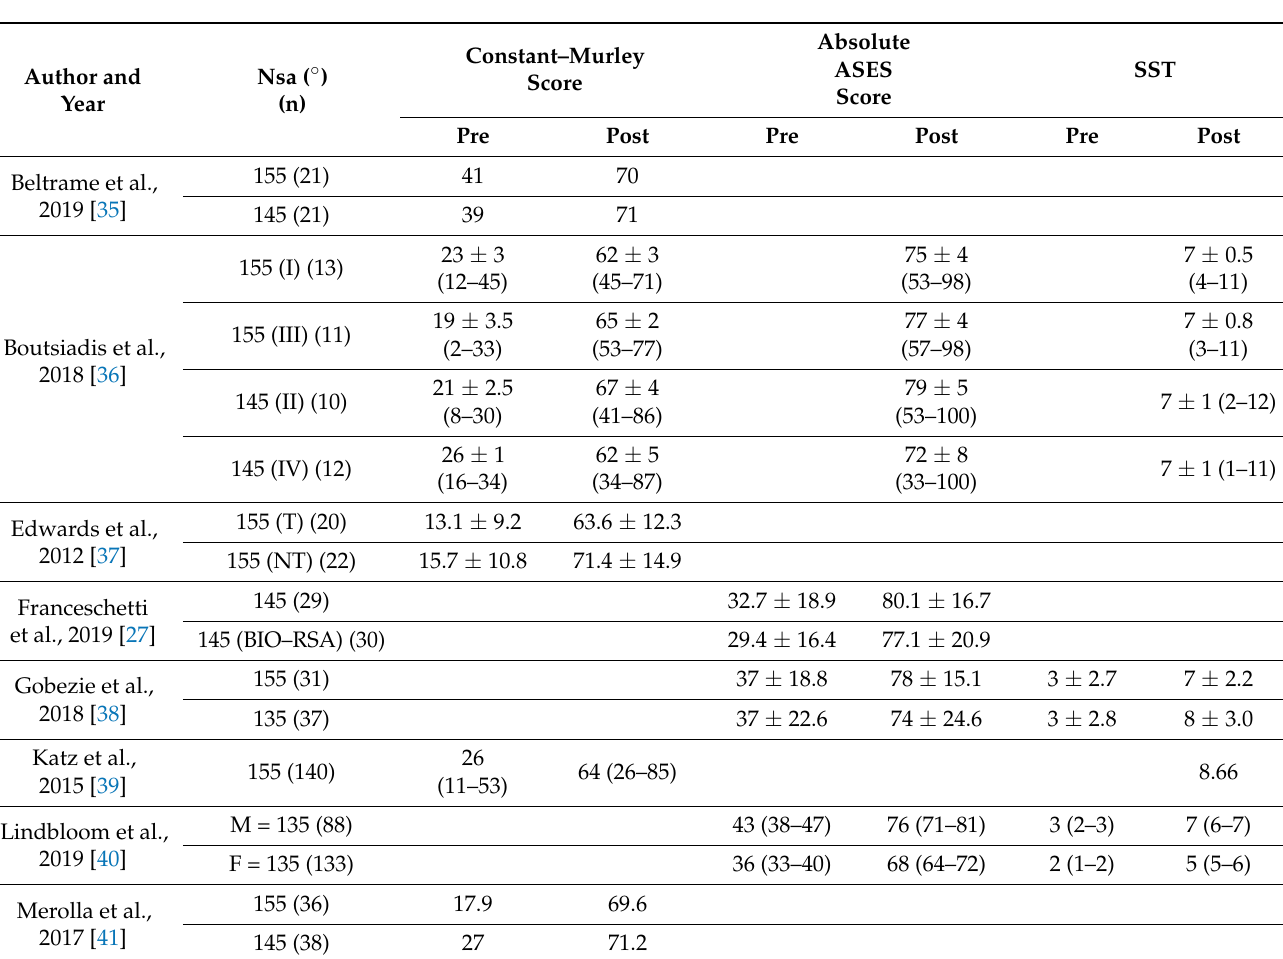
Table 3. Outcome measures of the studies included (absolute Constant–Murley score, ASES score, and simple shoulder